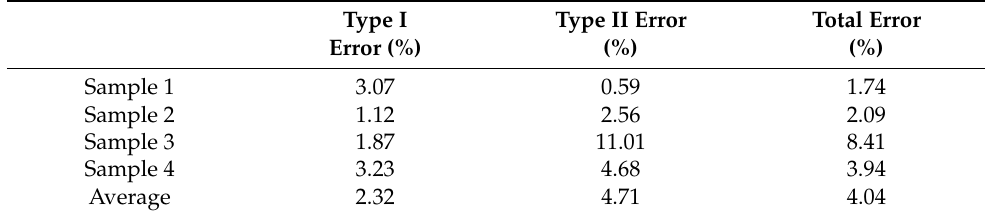
Table 3. Three types of errors of tree point